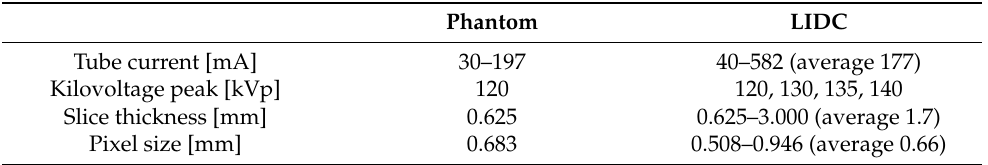
Table 2. Computed tomography (CT) scan parameters for both